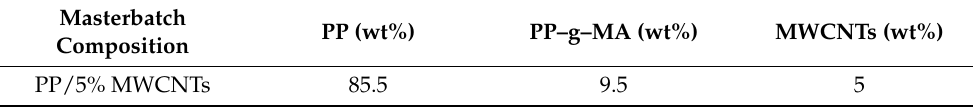
Table 2. Masterbatch composition and formula